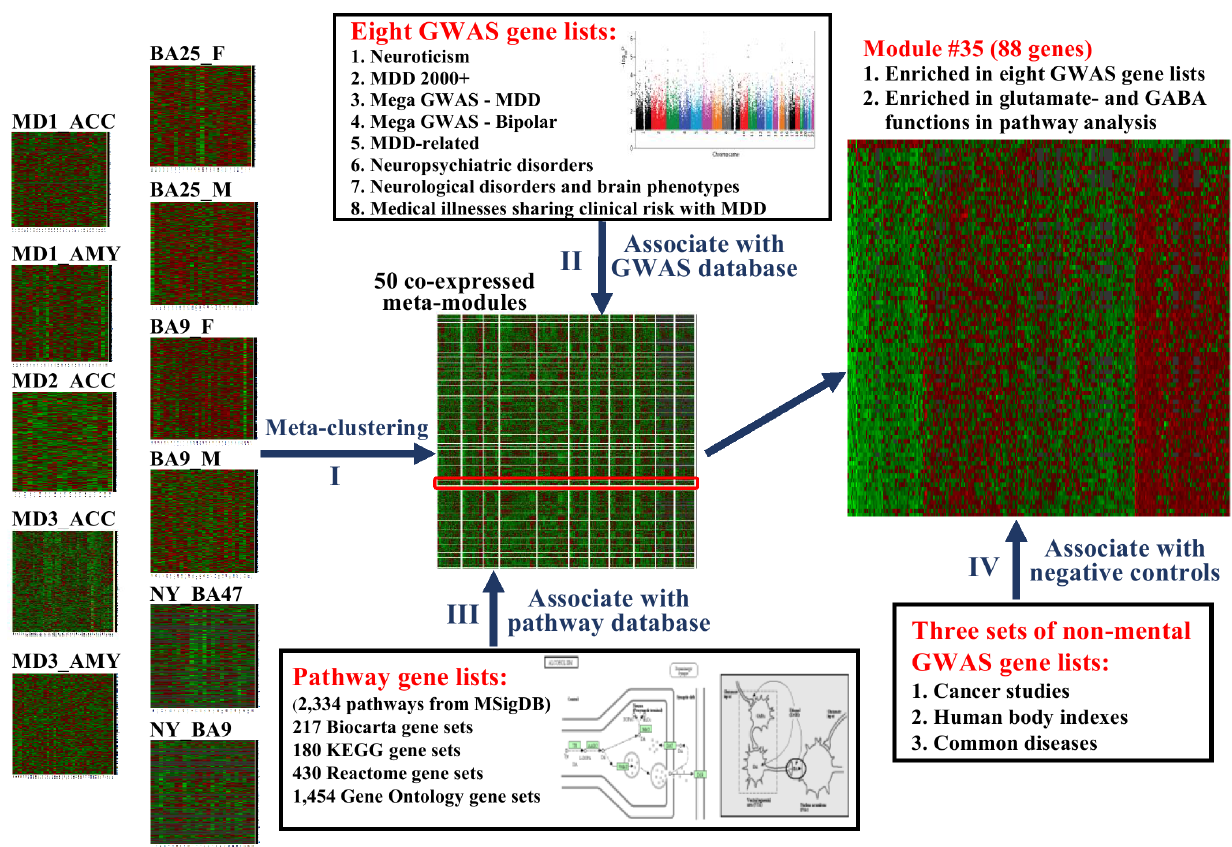
Figure 1. Overall analytical strategy. In step I, 50 co-regulation modules were generated using meta-clustering of gene clusters identified by the ‘‘penalized K-medoids’’ method across 11 transcriptome MDD and matched controls studies. In step II, modules enriched from most of the selected GWAS studies related to MDD, neuropsychiatric disorder and traits, including systemic disease linked to psychiatric disorders were identified. In step III, the biological functions represented by genes included in each module were defined by pathway analysis from 2,334 gene sets of MSigDB (www. broadinstitute.org/gsea/msigdb). In step IV, SNPs from the Catalog of GWAS were organized into three categories: cancer GWAS, human body indices GWAS and GWAS for common diseases and medial illnesses unrelated to MDD or other brain function. Three additional categories were defined as non-MDD-related negative control gene sets. (Note: In order to increase the performance of the heatmap in module # 35, we first performed the hierarchical clustering with ‘‘complete’’ agglomeration method to aggregated samples with similar expression among all 88 genes, and the genes were sorted by the correlation from high to low of selected genes in the top.).